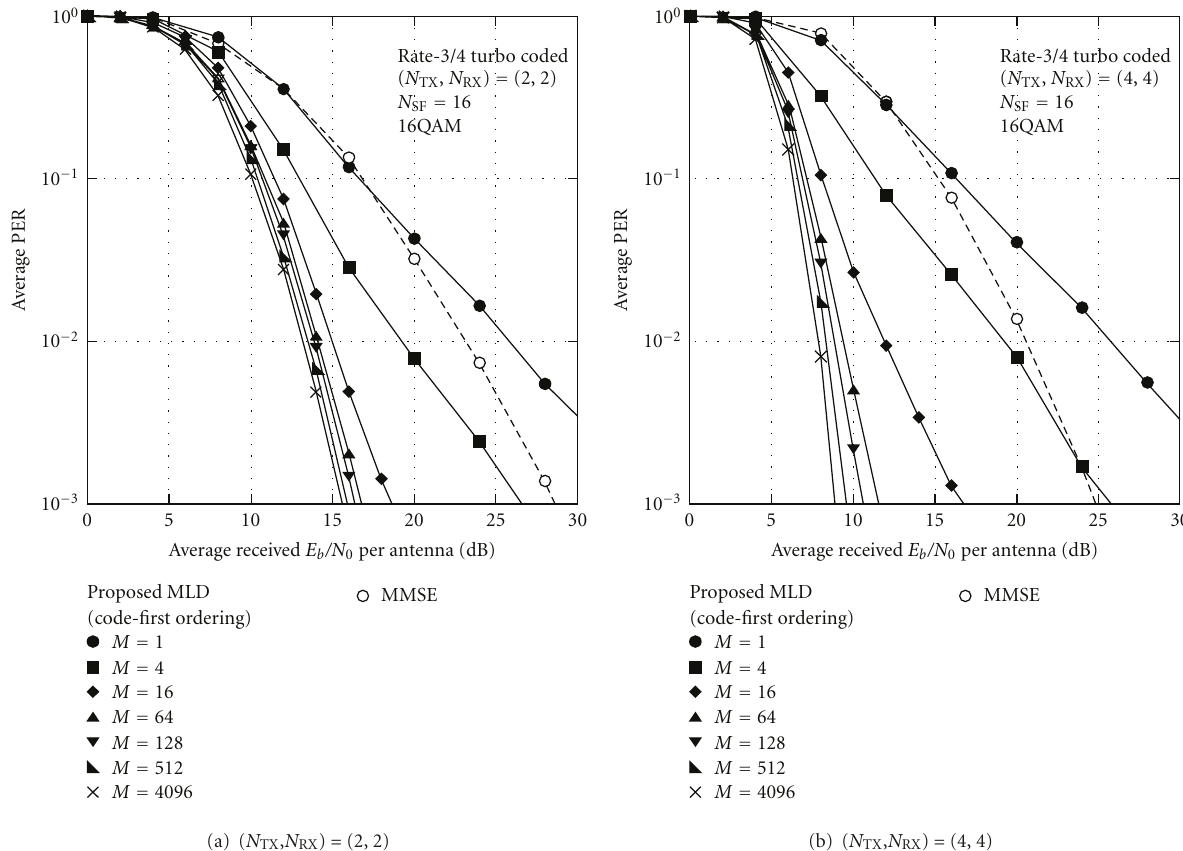
Figure 7: Average PER as a function of average received E b /N 0 (coded